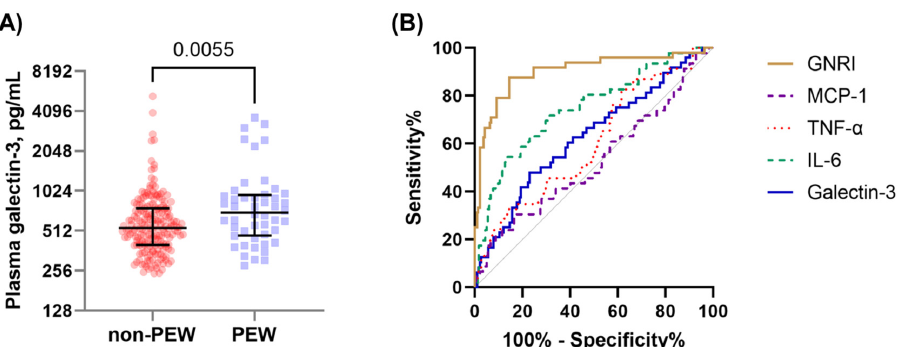
Figure 2. Plasma galectin-3 concentrations and predictive power for PEW in chronic hemodialysis patients. ( A ) In hemodialysis patients with PEW, plasma galectin-3 concentrations were significantly ( p < 0.01) elevated as compared to subjects without PEW. ( B ) Receiver operating characteristic (ROC) curve analyses comparing the predictive accuracy in identifying PEW of galectin-3 with other classical nutritional and inflammatory indices. Table 3. Receiver operating characteristic curve analyses of the diagnostic performance of inflammatory and nutritional markers in identifying the presence of PEW in maintenance hemodialysis patients.